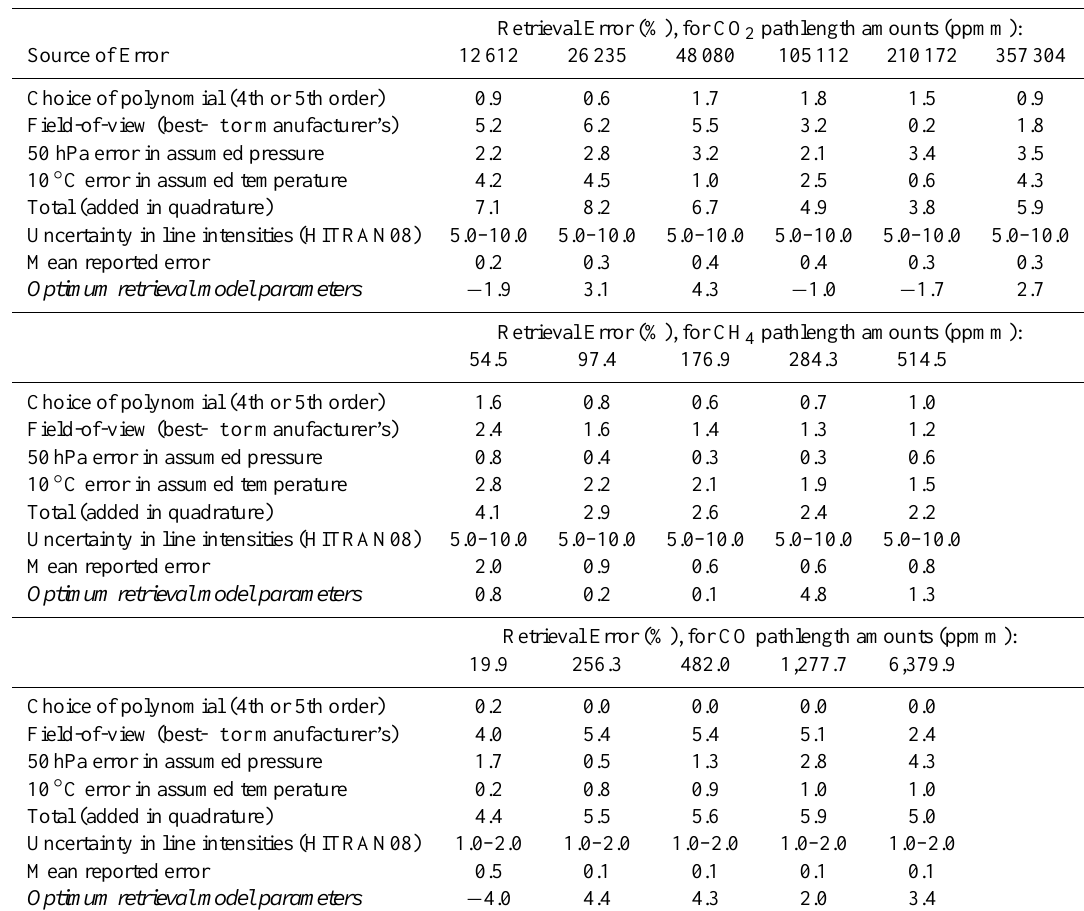
Table 3. Summary of errors associated with parameter uncertainty when retrieving trace gas amounts from OP-FTIR measurements using the MALT foward model of Griffith (1996) with a NLLS fitting procedure. Errors for choice of polynomial and errors in assumed field-of- view, pressure and temperature are taken from the results presented in Figs. 7, 9, 10 and 11, and are calculated using the difference between the retrievals made using the best parameter to those using the altered parameter, expressed as a percentage. For example, at an actual CO 2 pathlength amount of 12612ppmm, the retrieved CO 2 column amount based on the retrieval method parameterised with the optimum parameter values was underestimated by just under 2%. Uncertainties in the HITRAN08 database (Rothman et al., 2009) refer to the line intensity error specified